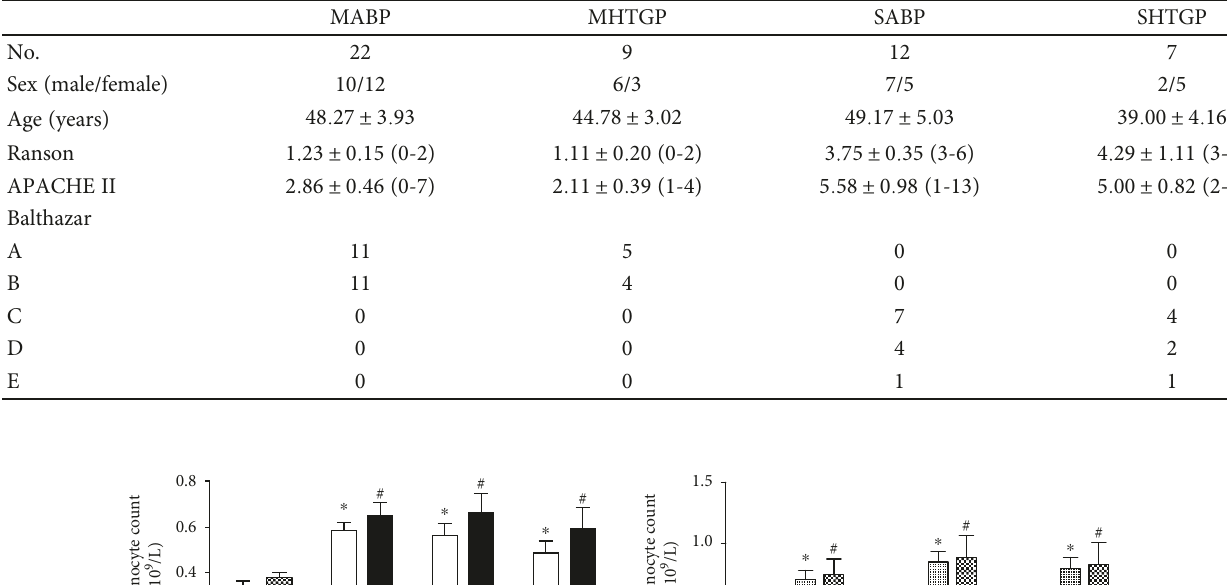
Table 2: Clinical characterization of patients with MABP, MHTGP, SABP, and SHTGP.